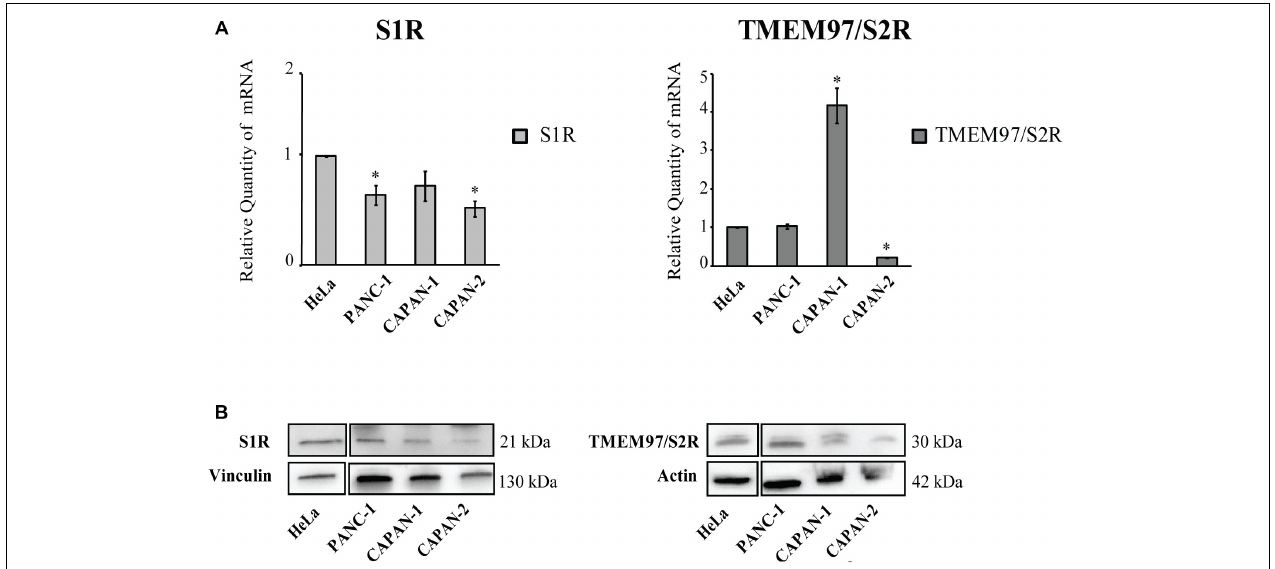
FIGURE 1 | Relative Quantification (RQ) of the target genes Sigma 1 and TMEM97/S2R. (A) Analysis were performed with Real-Time PCR. RNA expression was normalized to GAPDH and HPRT-1. The RNA gene expression was relative to HeLa cell line (RQ = 1). Values are the mean ± SD of three independent experiments.